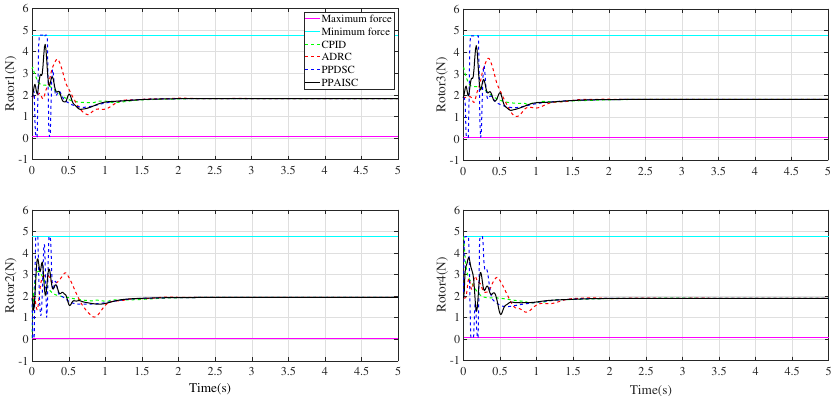
Figure 7. Time responses of thrust force generated by four rotors under different